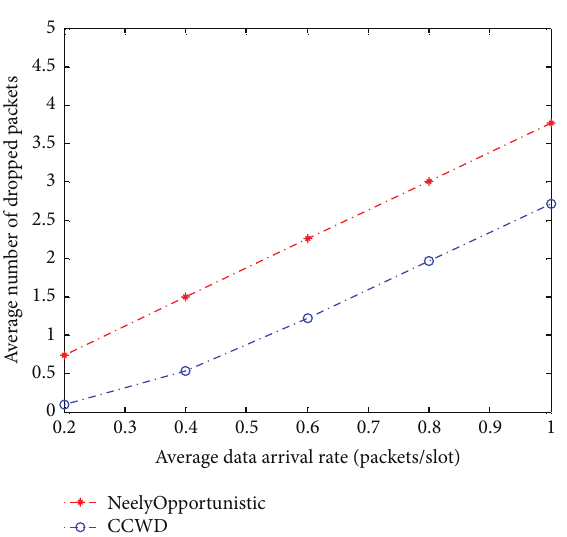
Figure 2: Time average number of dropped packets versus average data arrival rate.